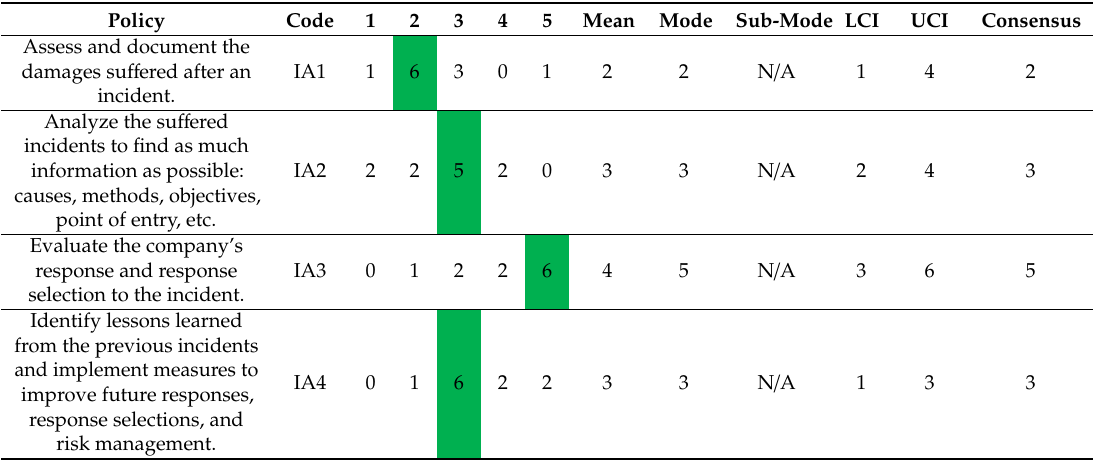
Table 14. Incident analysis policies’ starting